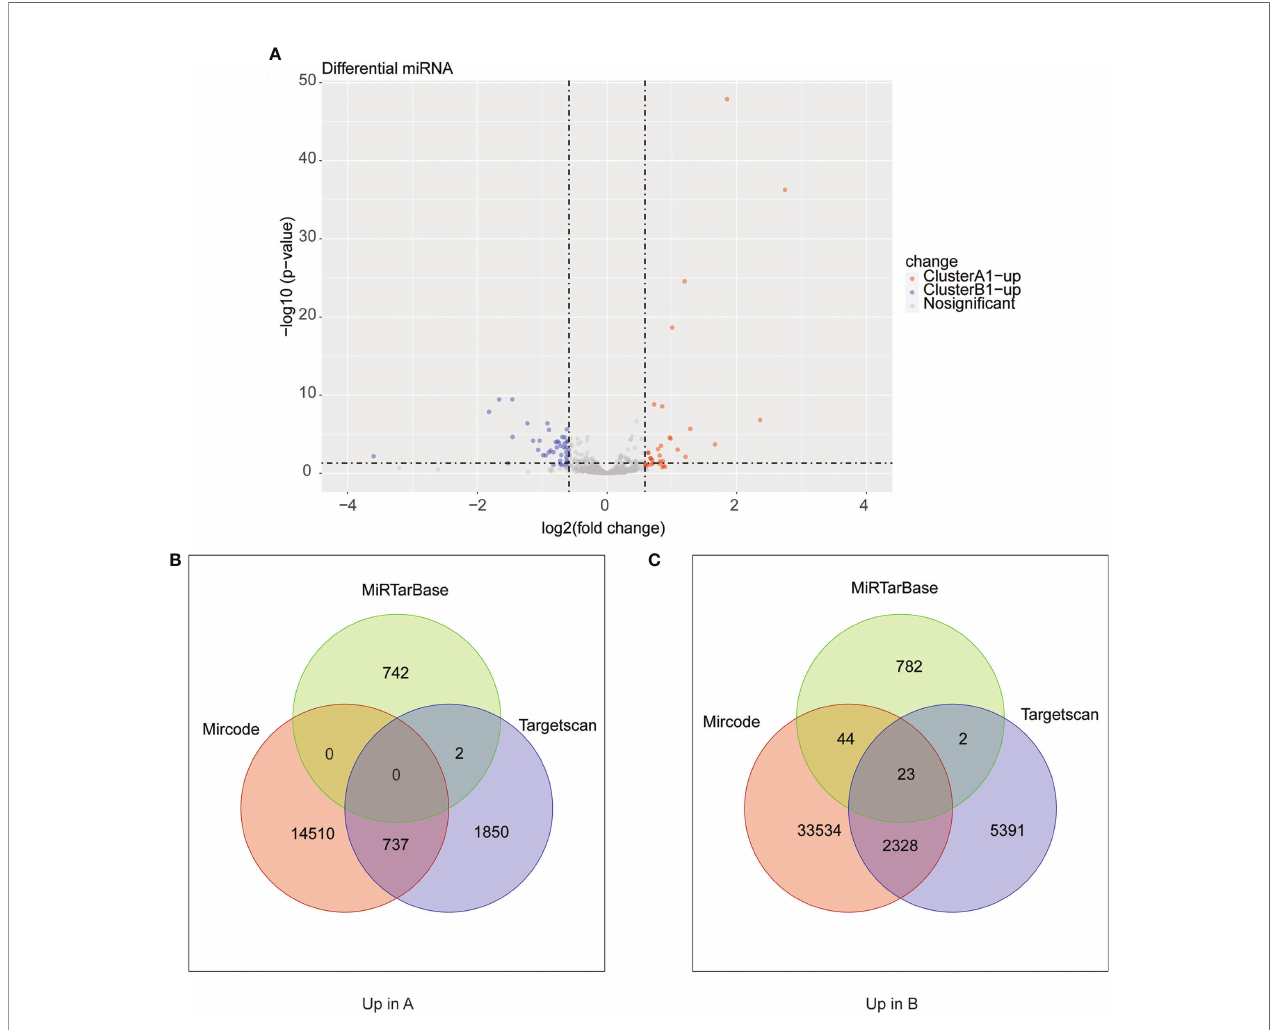
FIGURE 8 | (A) Heat maps of differential miRNA between clusters A1 and B1. (B, C) Venn diagram showing upregulated mRNA in cluster A (diagram B) and cluster B (diagram C) with miRNA – mRNA interaction pairs in datasets of mircode, miRTarBase, and